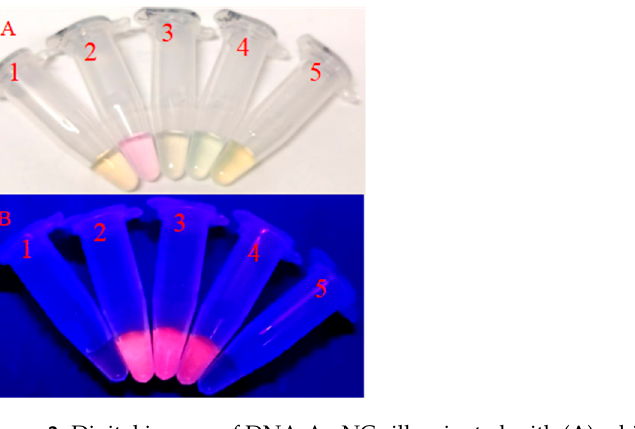
Figure 3. Digital images of DNA-Ag NCs illuminated with ( A ) white and ( B ) UV lights. 1–5 refer to the DNA1-Ag NCs to DNA5-Ag NCs.